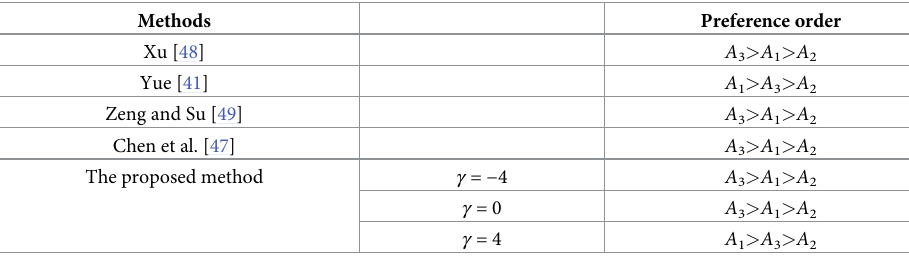
Table 13. A comparison of the orders of the alternatives of Example 2 for different